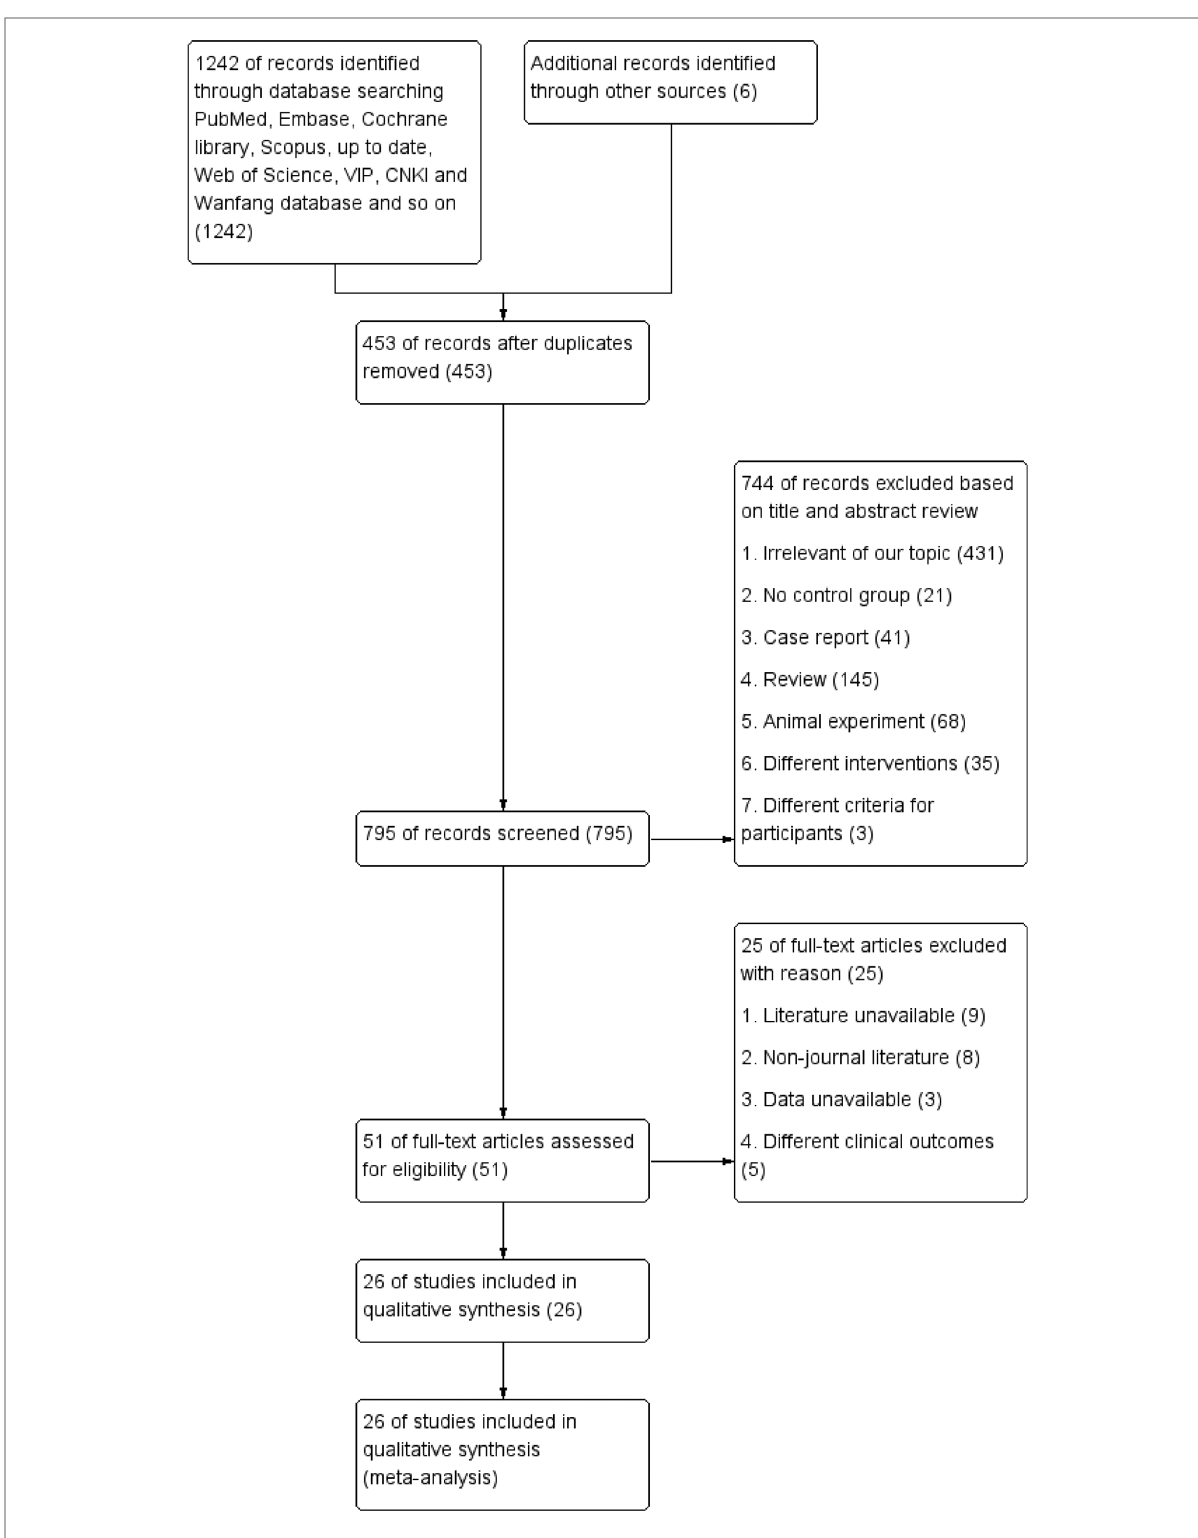
FIGURE 1 Flowchart of the